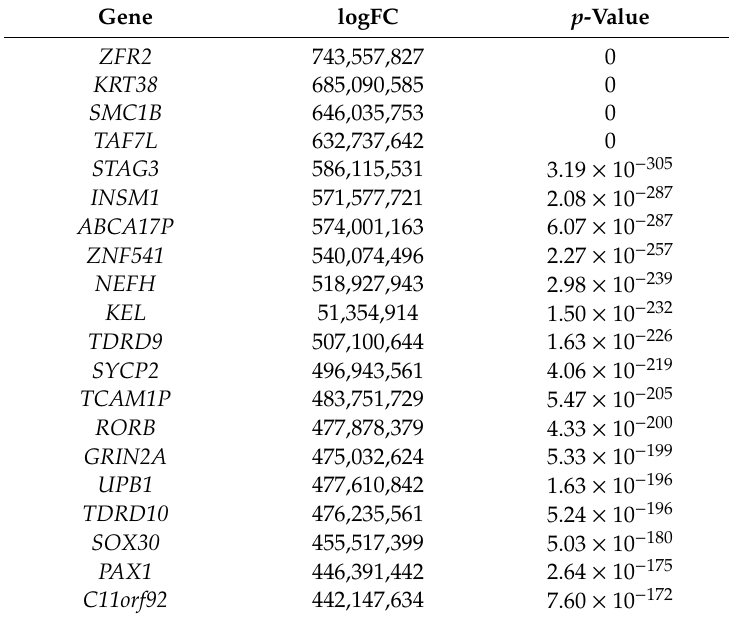
Table 6. DEGs in HPV ( + ) and HPV ( − ) tumour